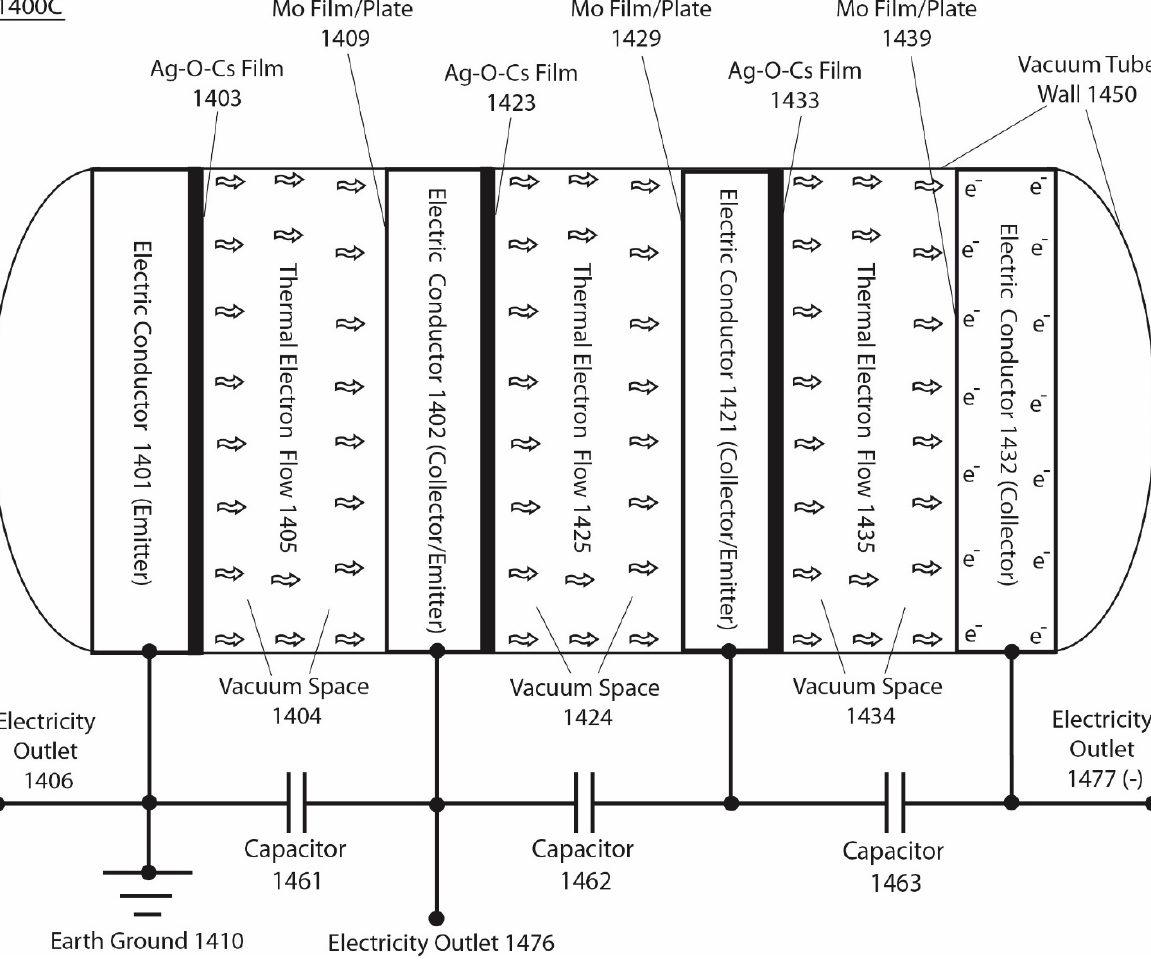
Figure 5. Presents an example of a prototype for an integrated isothermal electricity generator system 1400C that comprises three pairs of emitters (electron work function 0.7 eV) and collectors (work function 4.36 eV) installed in a vacuum tube chamber.